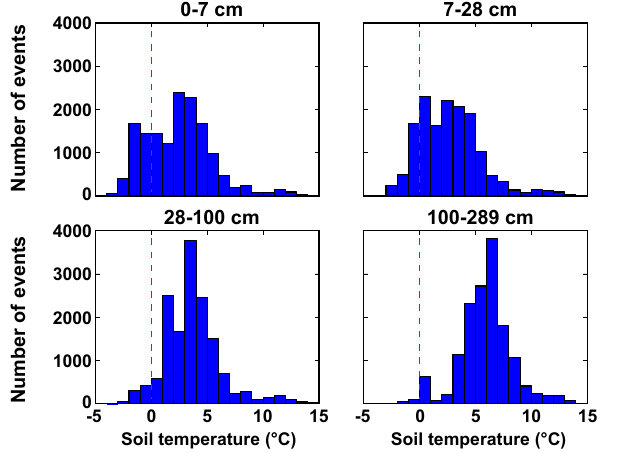
Figure 2. Histograms of ERA-Interim temperatures for four differ- ent soil levels leading to observed forest damage. The red dashed line highlights the 0 ◦ C